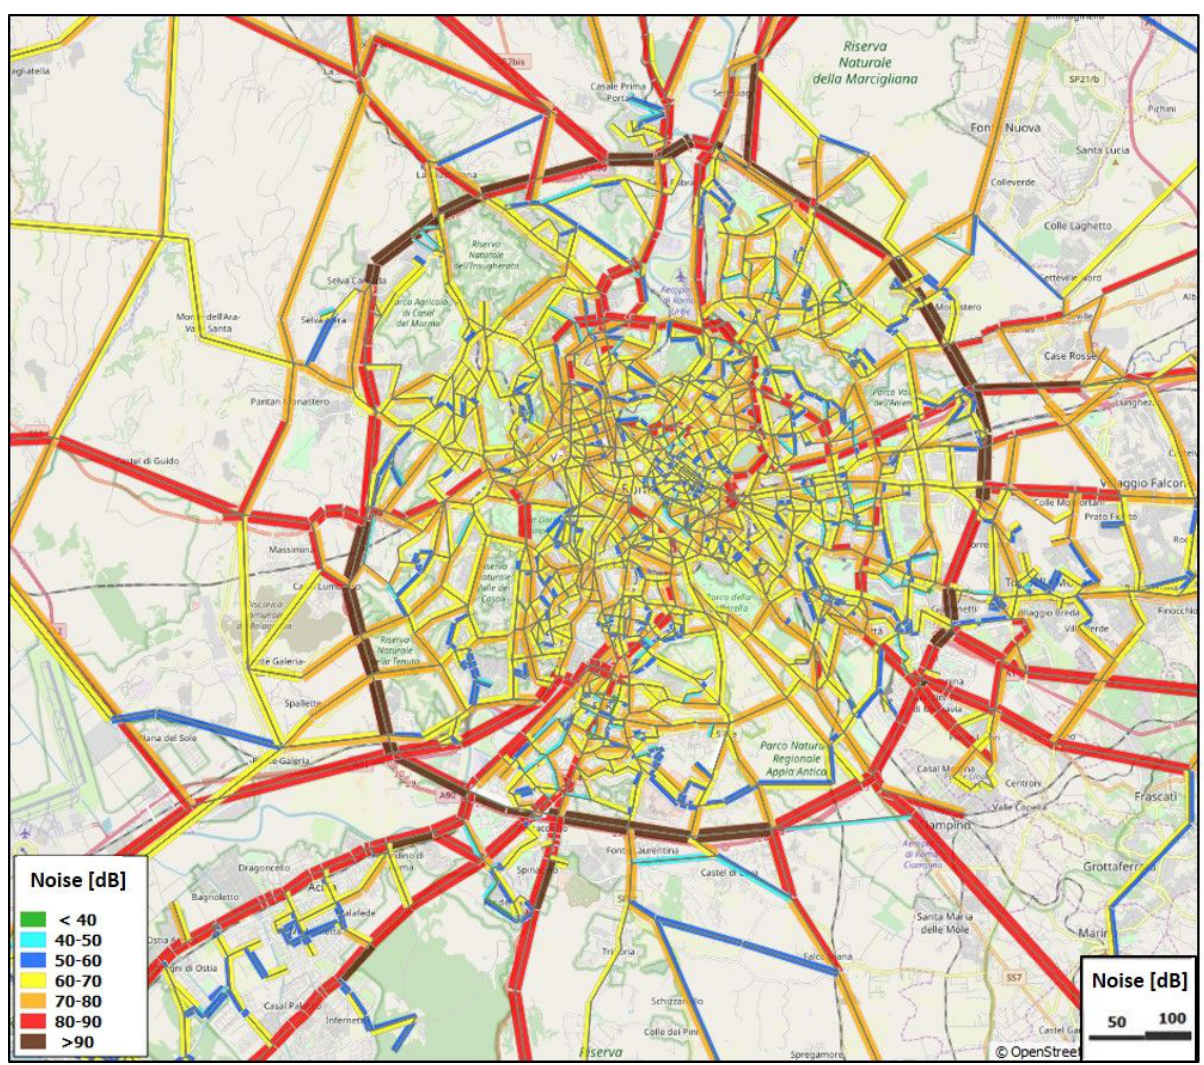
Figure 3: Noise emissions [dB], 100% AVs scenario